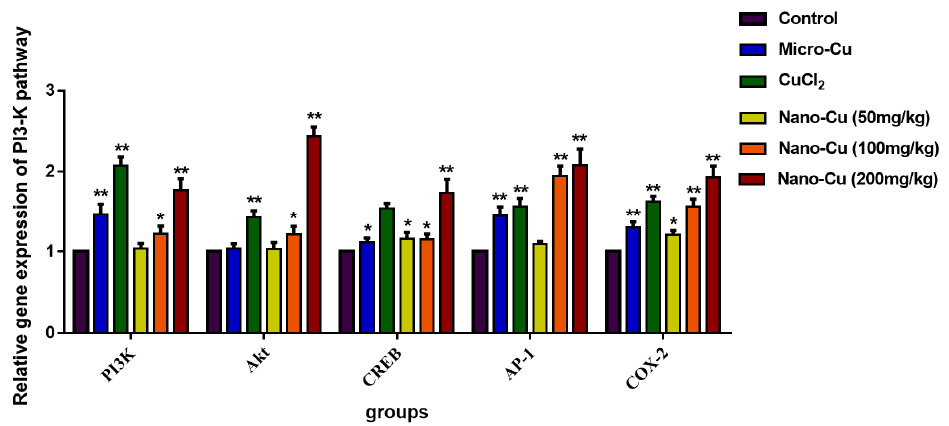
Figure 6. Expression levels of genes of the signaling pathway in rats given copper-containing preparations by oral administration for 28 consecutive days (2 −ΔΔ CT ). * p < 0.05 and ** p < 0.01 vs. control. Values represent means ± SD ( N = 10).